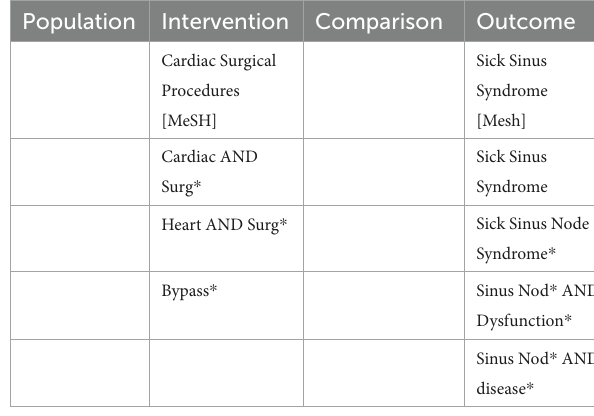
TABLE 1 Key terms used in search